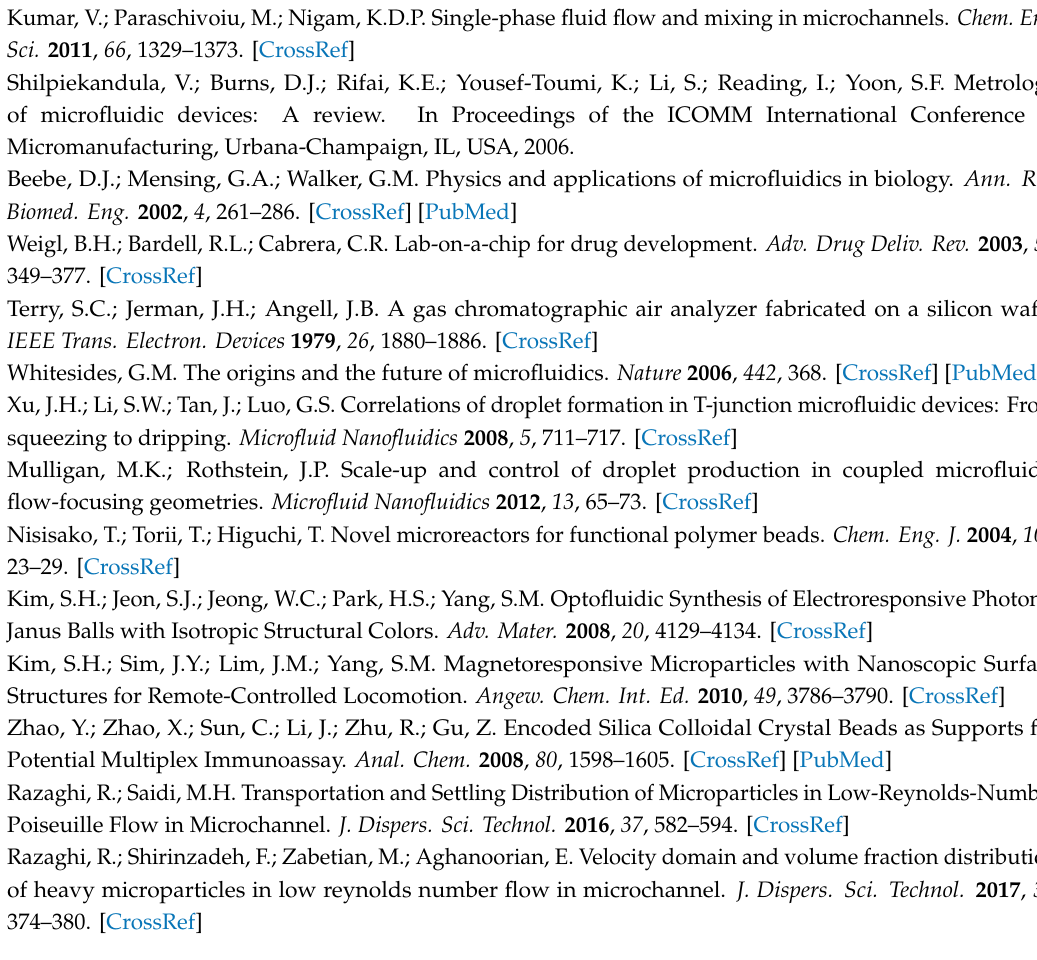
Figure S1: Droplet size distribution in di ff erent region of interests at Qd of (a) 0.5 mL / hr; (b) 1.5 mL / hr; and (c) 2.0 mL / hr, respectively. The images were taken under the optical microscope using high speed camera, Figure S2: Droplet size distribution in di ff erent region of interests at Qc of (a) 0.5 mL / hr; (b) 1.5 mL / hr; and (c) 2.0 mL / hr, respectively. The images were taken under the optical microscope using high speed camera, Figure S3: Droplet size distribution in di ff erent region of interests at Qd of (a) 0.5 mL / hr; (b) 1.5 mL / hr; and (c) 2.0 mL / hr, respectively. The images were taken under the optical microscope using high speed